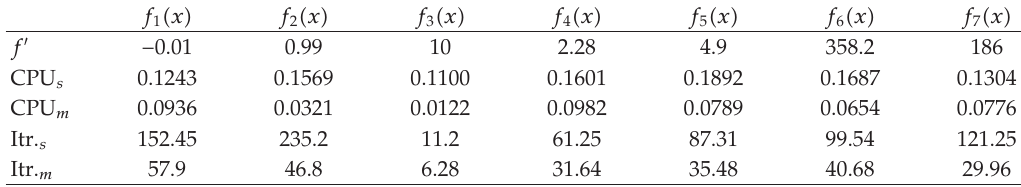
Table 2: Summary of simulation results, with an achievement level as a termination